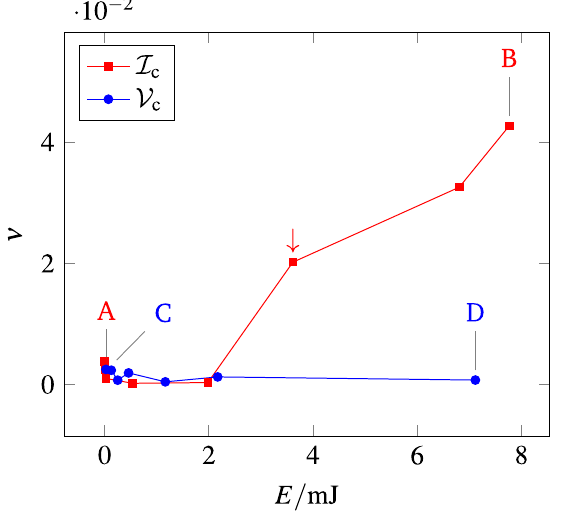
Figure 4. The symmetry index ν of sample S calculated from ERT measurements for increasing E performed at I V c and c . Letters and arrow label the values of ν corresponding to the maps shown and discussed in the